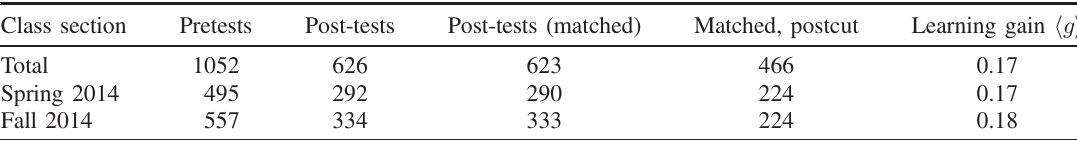
TABLE I. Summary of the collected TOAST surveys used in this study. Summary of data obtained from TOAST surveys of two sections of ASTRO 001V. The “ Total ” learning gain is calculated by combining the data from the two